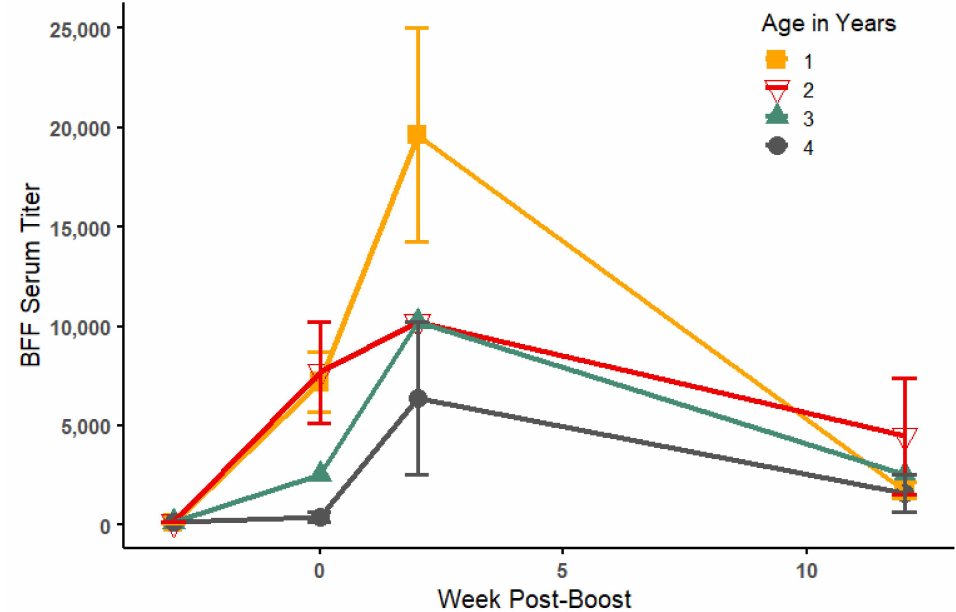
Figure 3. Mean anti-SARS-CoV-2 serum titers for immunized black-footed ferrets as measured by enzyme-linked immunosorbent assays (ELISA) by age and week post-boost. Error bars represent the standard error of the mean. For the purposes of visualization, animals that were bled at 2 or 3 weeks post-boost were grouped here as a single data